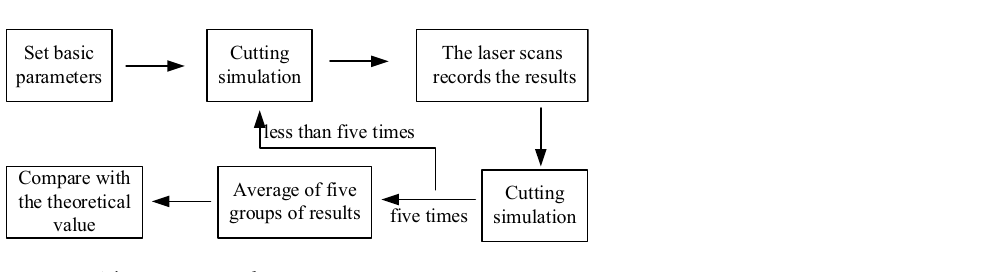
Figure 8. The experimental